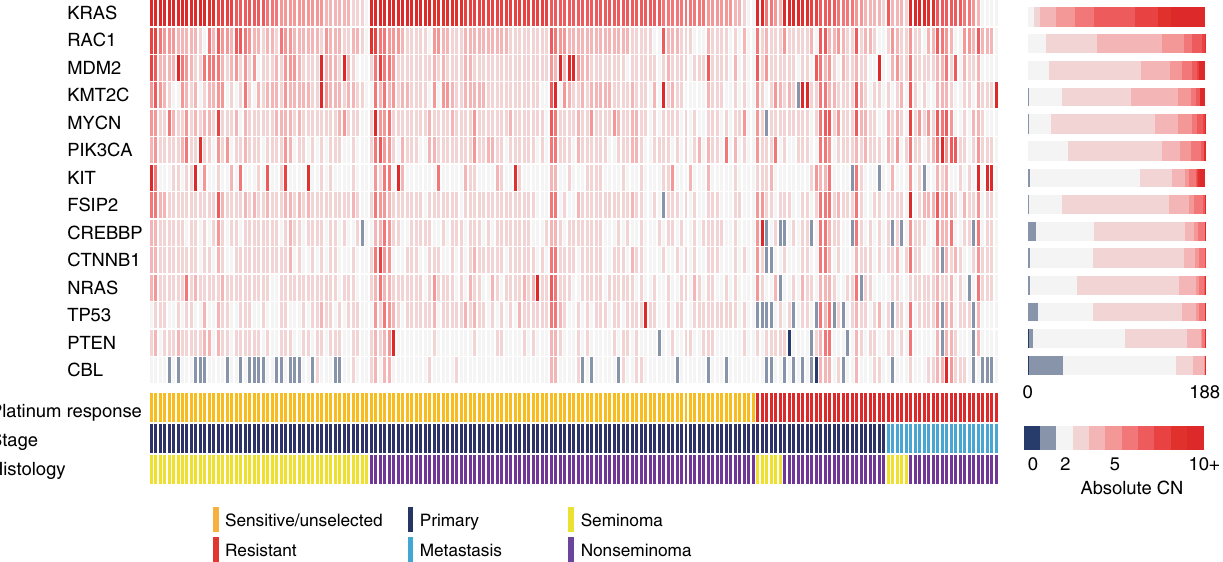
Fig. 5 Absolute copy number of driver genes. Plot showing the absolute copy number in 183 TGCTs with available copy number data and tumour purity ≥ 0.4 (ICR1, ICR2, DFCI and TCGA sample series) for fourteen genes including the putative/known TGCT driver genes ( KIT , KRAS , NRAS , RAC1 , CBL , PIK3CA , CREBBP , KMT2C , CTNNB1 ), TP53 and PTEN , and three genes previously implicated as focally ampli fi ed in TGCT, namely FSIP2 , MDM2 and MYCN 9,10,13 . Genes are ordered vertically from most to least frequently demonstrating copy gain.